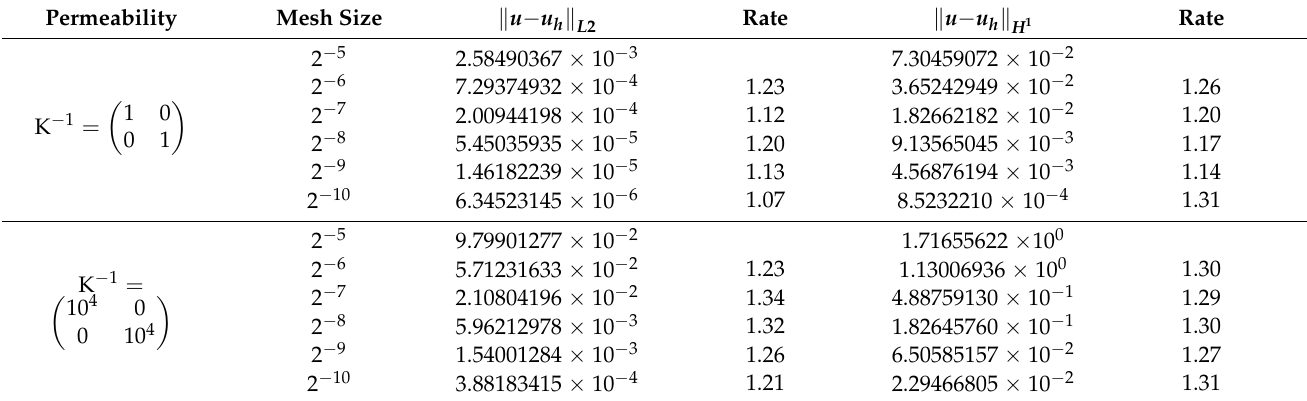
Table 1. Numerical error and convergence rates for example